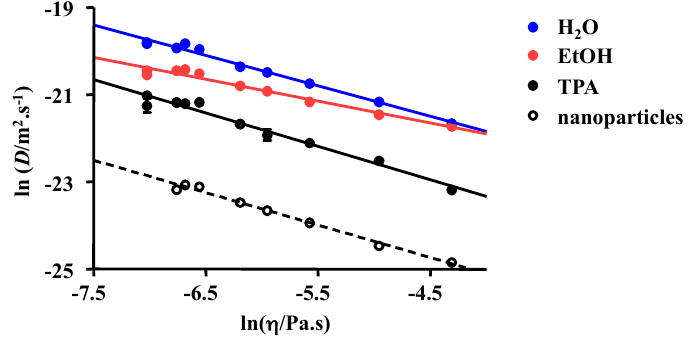
Figure 5. Dependence of diffusion coefficients on the viscosity in the 25 TEOS:9 TPAOH: x H 2 O system ( x = 152–15,000): closed circles correspond to water, ethanol, and TPA species according to 1 H DOSY NMR, and open circles to nanoparticles according to diffusion light scattering (DLS). The viscosities and DLS data are taken from Follens et al [62].